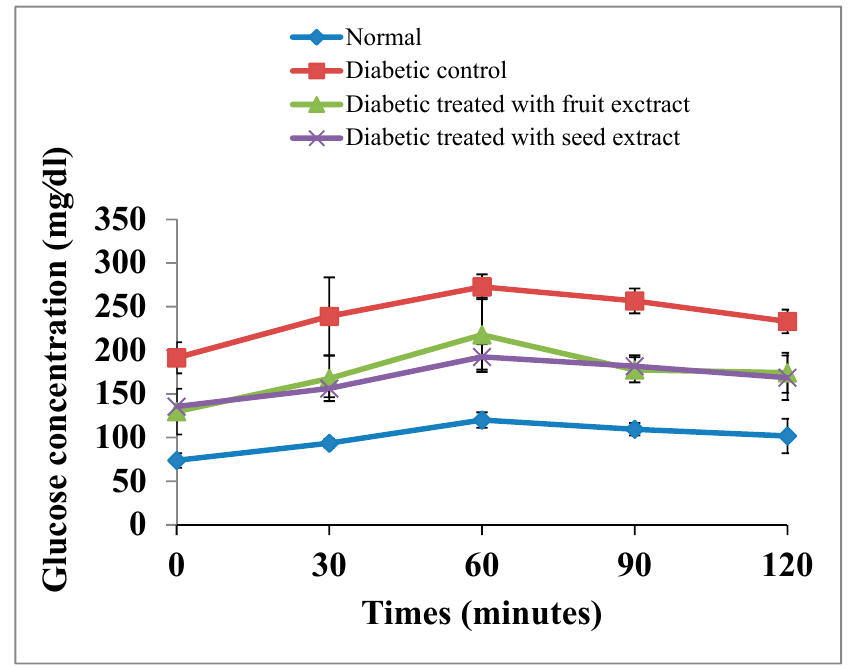
Figure 3. Effects of the B . aegyptiaca fruit and seed extracts on OGTT in NA/STZ-induced diabetic rats.